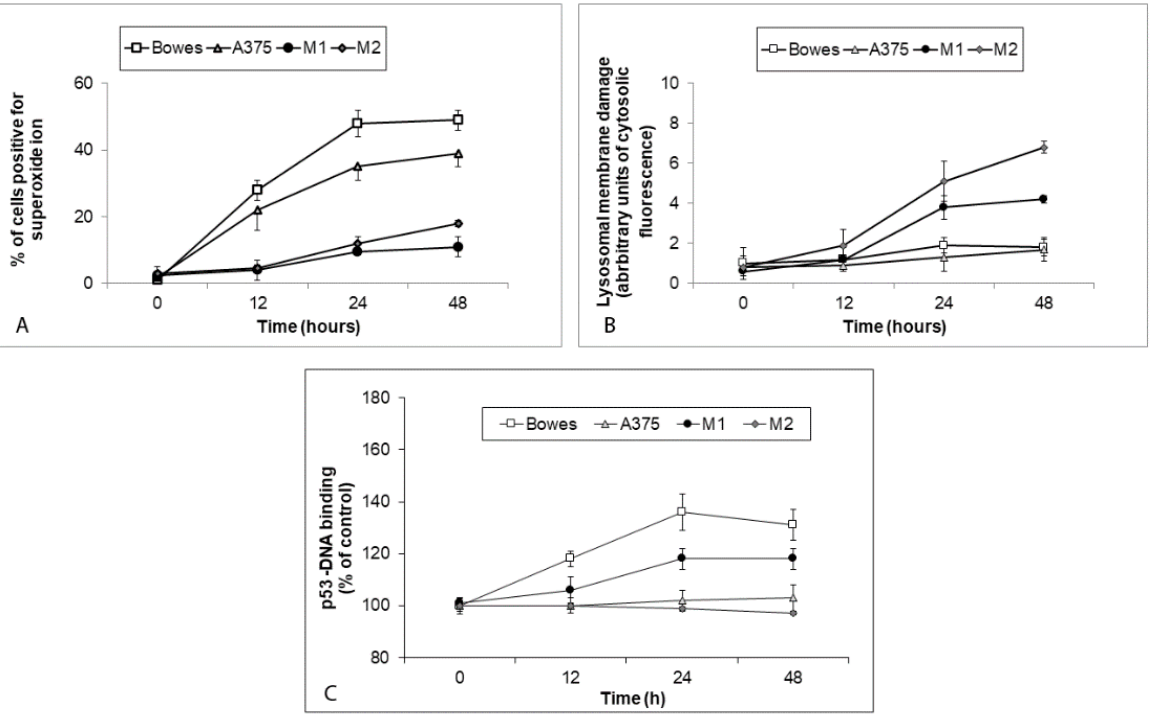
Figure 9. Generation of superoxide, lysosomal membrane damage and p53 activity in human melanoma cells Bowes and A375 and melanoma explant cultures M1 (low free zinc) and M2 (high free zinc) exposed to 25 µ M TPEN during 48 h. In exposed cells ( A ) superoxide levels ( B ) lysosomal membrane damage and ( C ) changes in p53 activity were measured as described in Materials and methods section. Results represent means ± SD of at least three independent experiments.